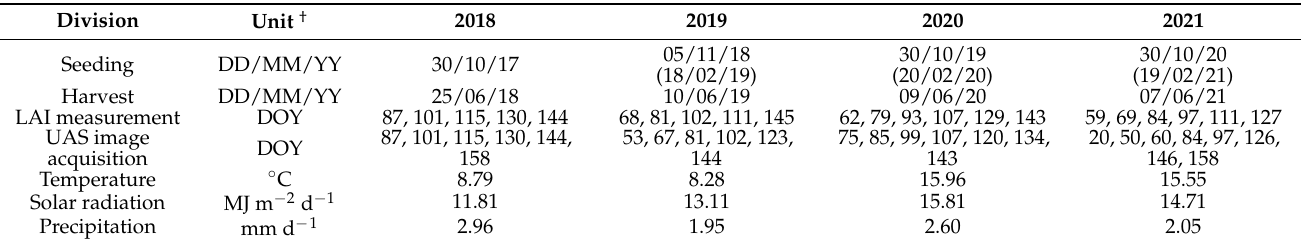
Table 1. Records of seeding, harvest, leaf area index (LAI) measurements, unmanned aerial system (UAS) image acquisitions events, and daily mean weather conditions during the barley and wheat growing seasons from 2018 to